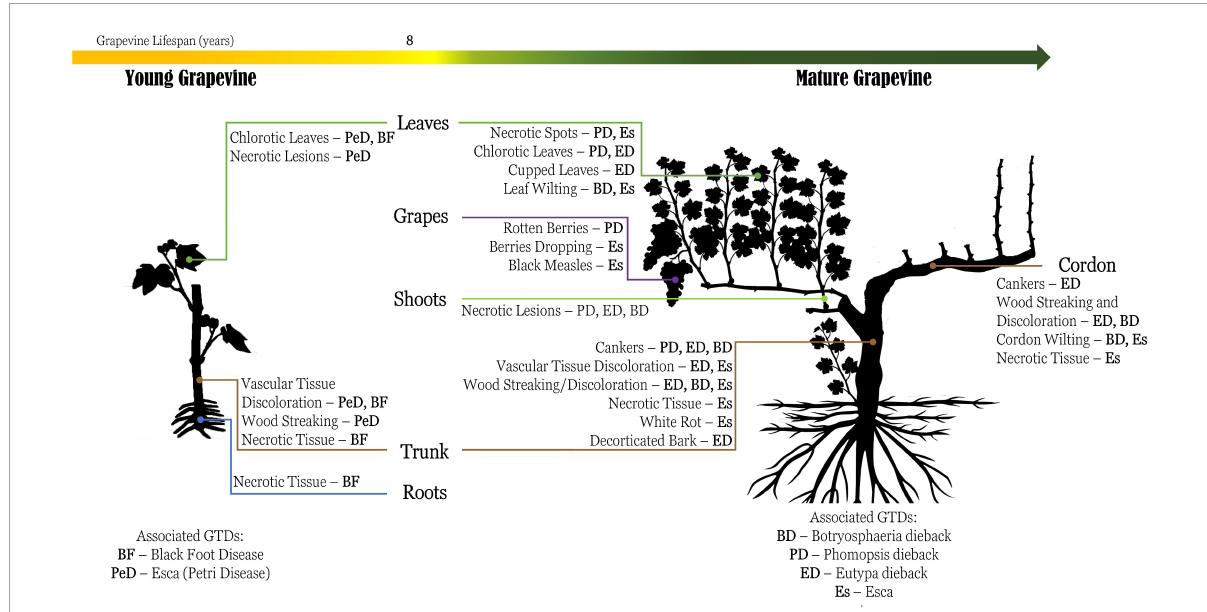
FIGURE2 Schematic representation of the commonly known symptomology regarding grapevine trunk diseases (GTDs), based on the description of the reviewed literature. Generally, the main effect caused by GTDs is stunted development of the vines and necrosis, partially or completely, which can lead to the decay of the plant and consequently production loss. Esca (Es), Petri disease (belonging to Esca complex) (PeD), Botryosphaeria dieback (BD), Eutypa dieback (ED), Phomopsis dieback (PD), and black foot disease